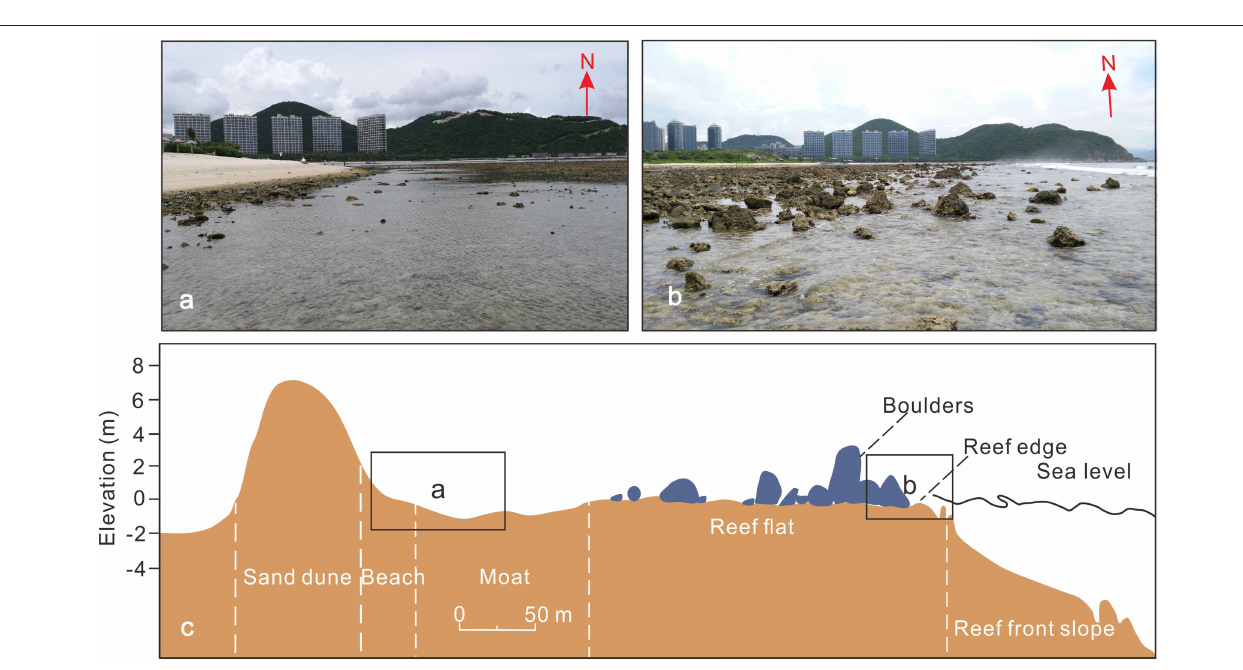
FIGURE 3 | (a) The majority of boulders were deposited 40–140m from the edge of the reef flat, whereas a few were transported nearer to the beach. (b) Carbonate boulders lying near the reef edge. (c) The generalized profile and zonation of the XDH study site [modified from Zhang